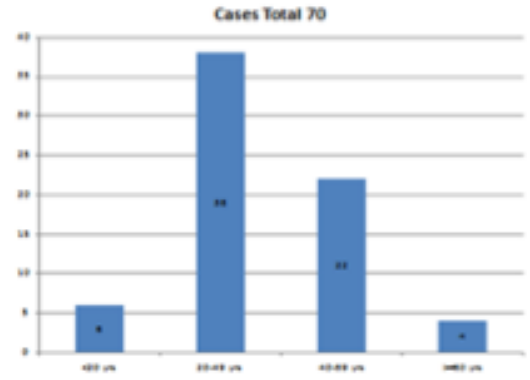
Figure 1: Bar diagram showing age group distribution of the patients.